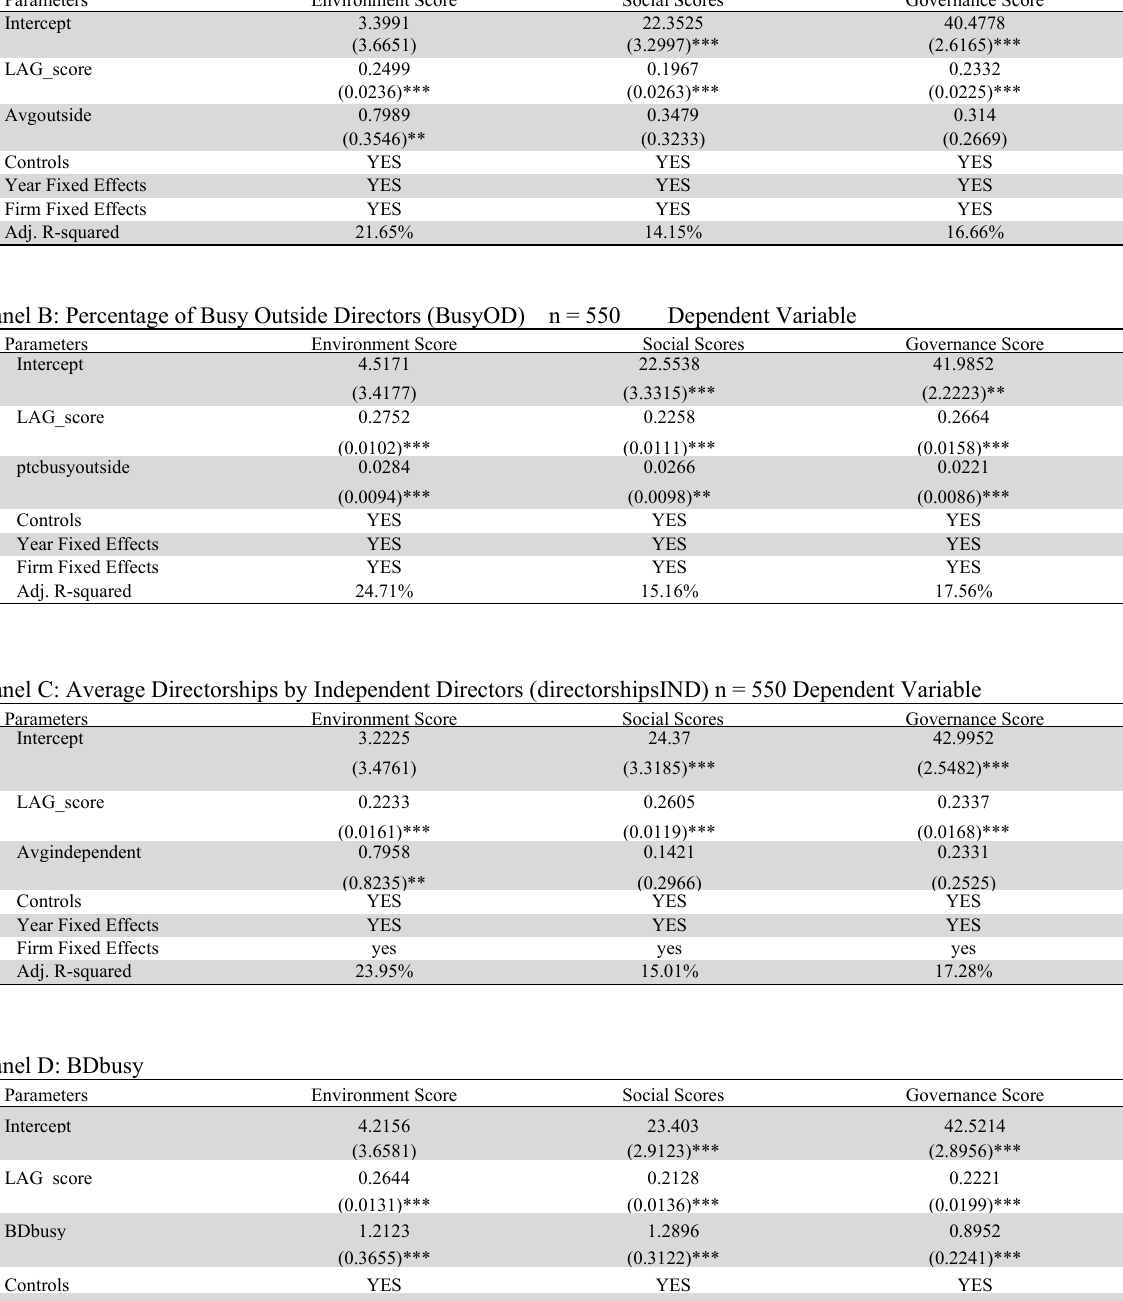
Environment, Social and Governance Score Regressions 4 Panel A: Average Directorships by Outside Directors ( AverageOD) n = 550 Dependent Variable Parameters